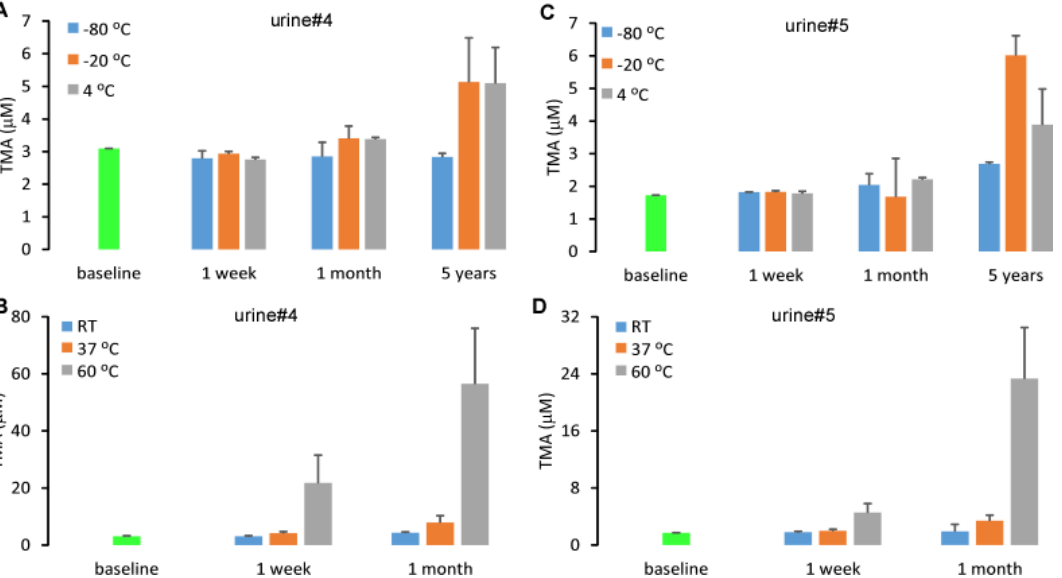
Molecules 2020 , 25 , x 11 of 16 Figure 7. Urine TMA concentration changes during storage. Two urine samples were stored at di ff erent temperatures, − 80 ◦ C, − 20 ◦ C 4 ◦ C ( A , C ), room temperature (RT), 37 ◦ C and 60 ◦ C for varying times ( B , D ). Urine TMA was extracted with hexane / butanol under alkaline pH with d9-TMA as an internal standard and quantified by LC / MS / MS. Data were presented as mean ± SD from two replicates. Additionally, due to its gaseous properties, TMA may be volatile during storage. In order to